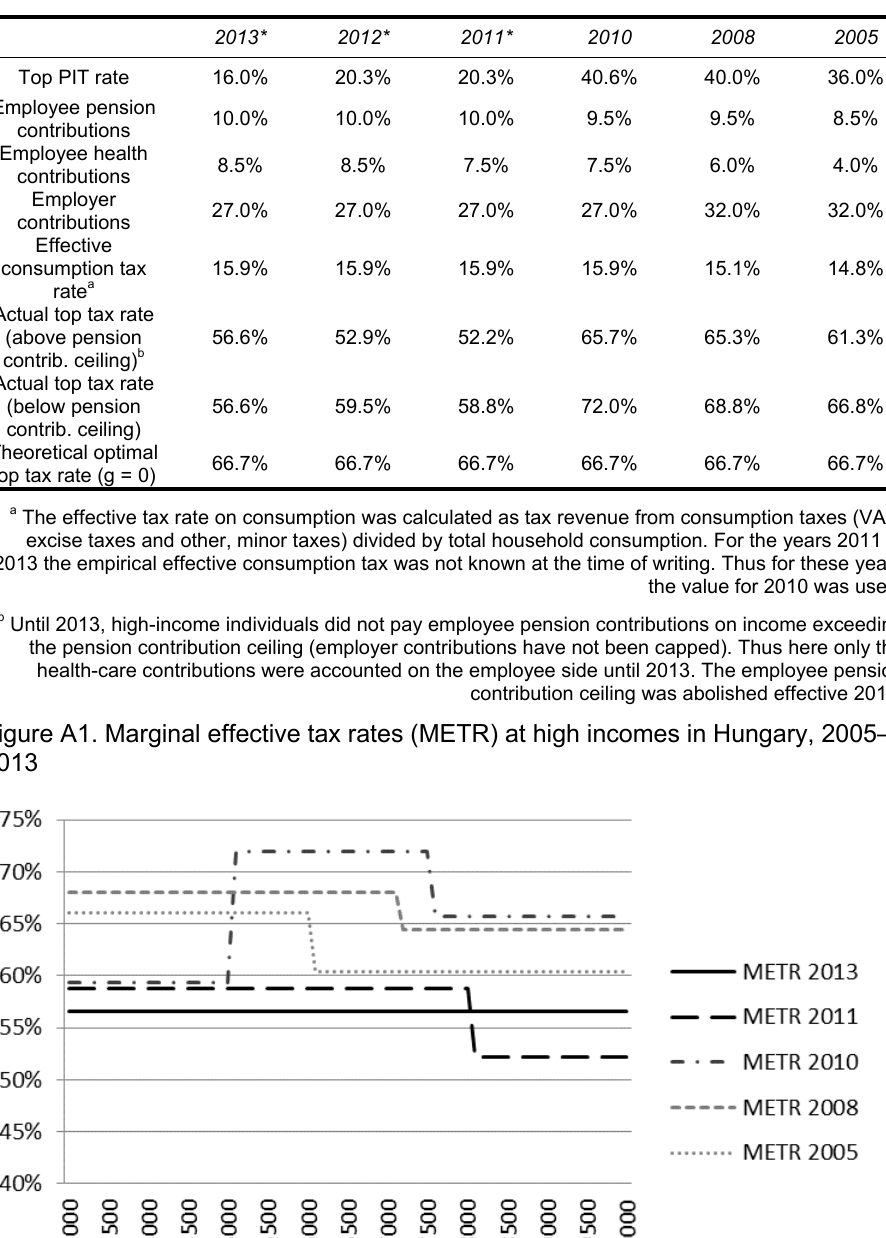
Table A1. Actual top tax rates in Hungary, 2005-2013